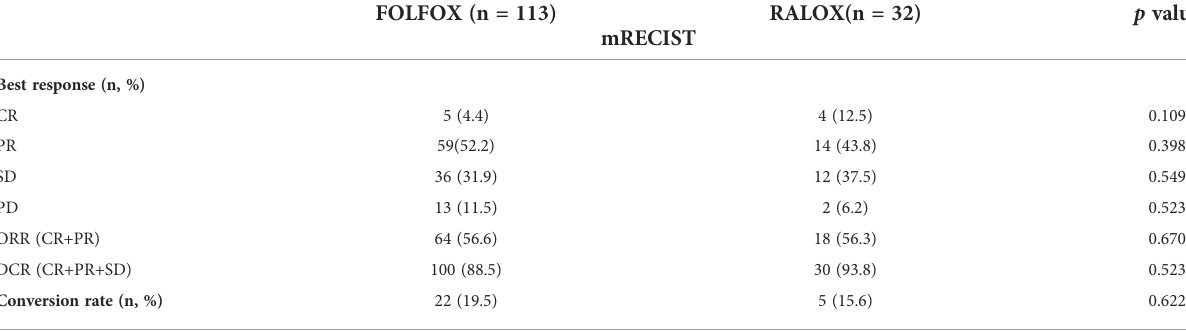
TABLE 3C Subgroup analysis according to HAIC regimen (FOLFOX vs RALOX).